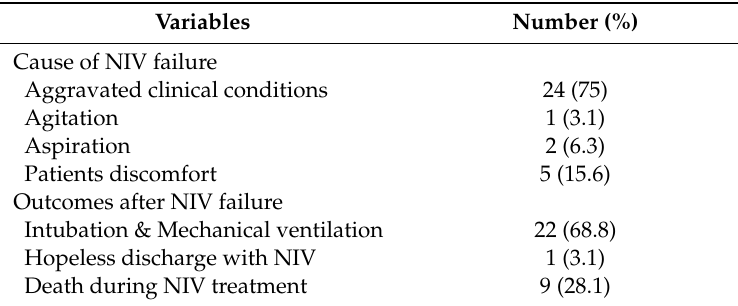
Table 3. Causes and Outcomes in patients with NIV failure ( n = 32).